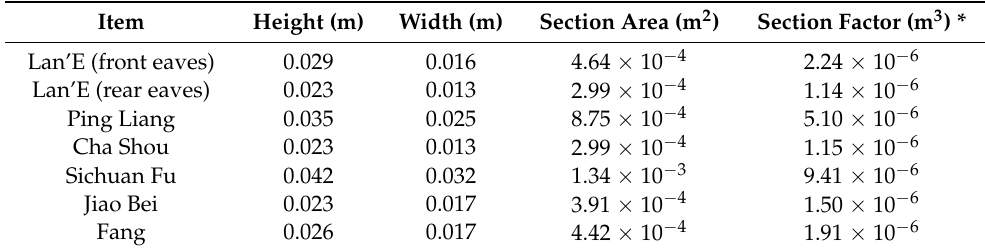
Table 2. Cross-sectional factors for individual components. Item Height